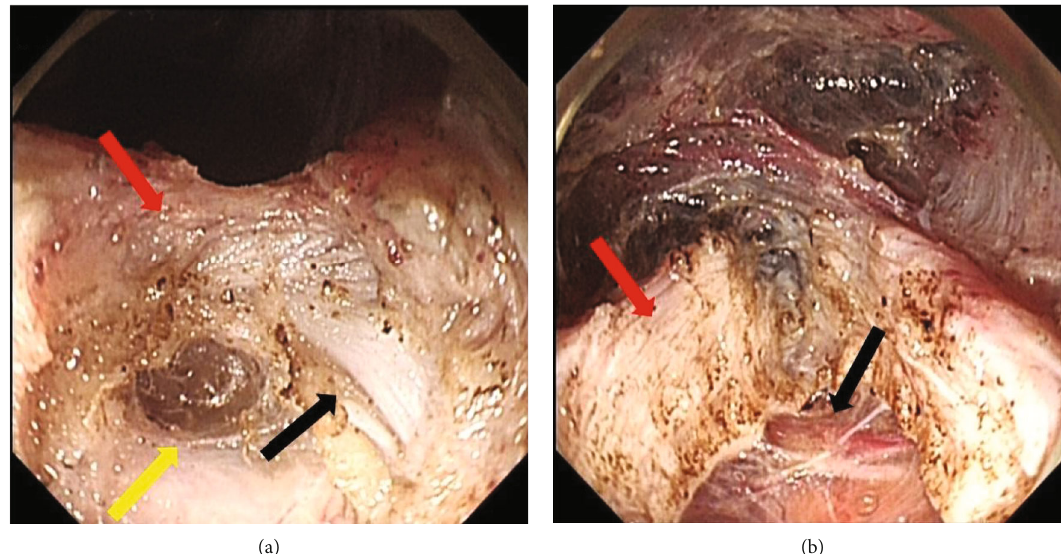
Figure 1: (a) The red arrow indicates the circular muscle layer, the black arrow indicates the longitudinal muscle layer, and the yellow arrow indicates the external coat of the esophagus. (b) The red arrow indicates the circular and longitudinal muscle layers, and the black arrow indicates the external coat of the